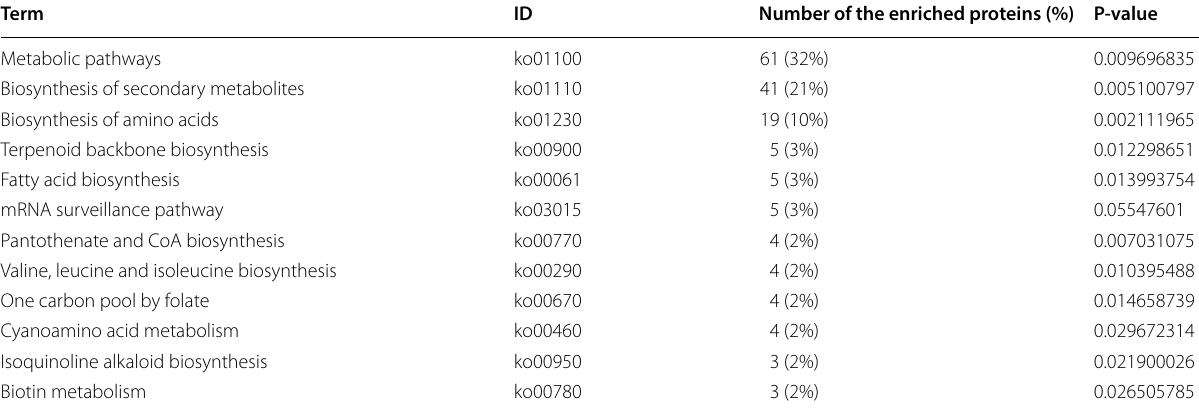
Table 1 KEGG pathway enrichment for the upregulated DCPs Term ID